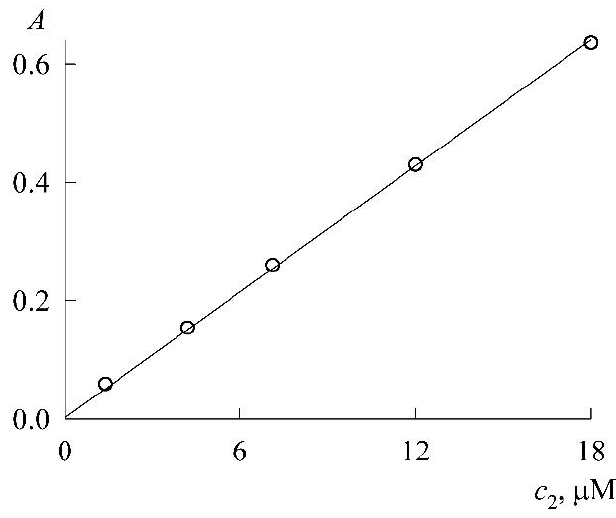
Figure 6. Calibration curve for NR in 30 mM SDS solution at the wavelength of 579 nm.